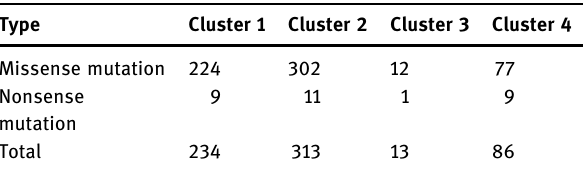
Table 2: Statistics of the number of mutant genes in di ff erent subgroups